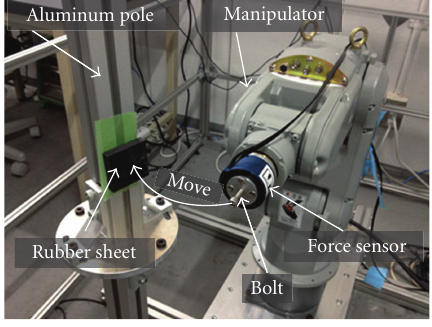
Figure 13: Experimental